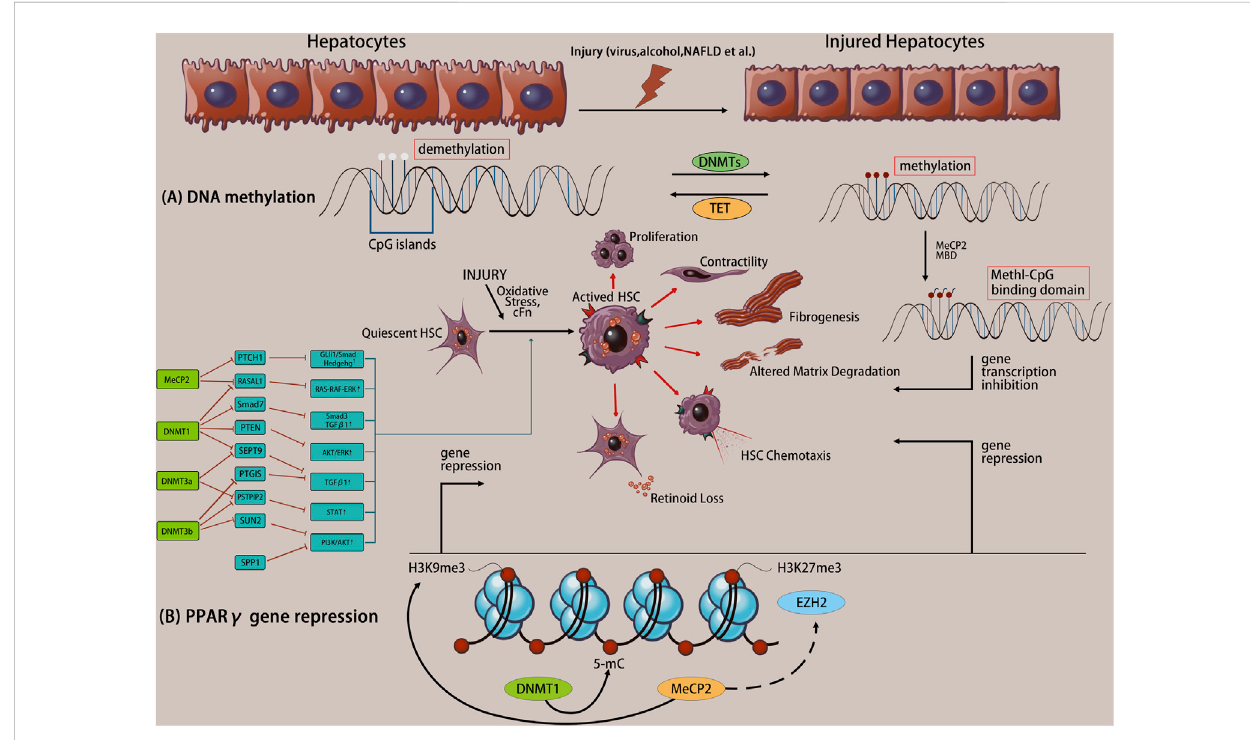
FIGURE 1 Liver injury initiates the transdifferentiation of quiescent hepatic stellate cells (HSCs) to their activated phenotype. Altered DNA methylation causes speci fi c gene expression/repression processes in response to speci fi c phenotypic changes, including proliferation, contractility, fi brosis, matrix degradation,chemotaxis,retinoidloss,etc. (A) ThemoleculemechanismofDNAmethylation. (B) ExampleofcoordinatedDNAmethylationregulationof PPAR γ transcriptional repression in activated